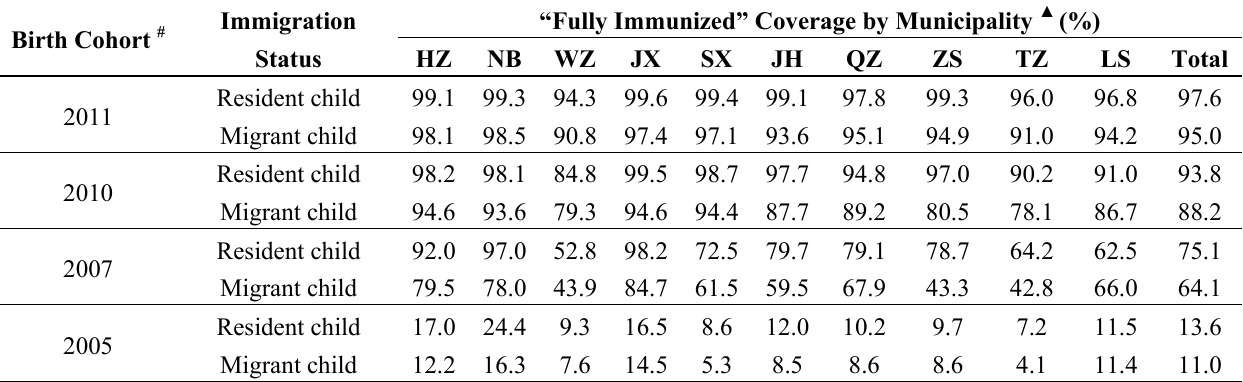
Table 7. Percentage of children “fully immunized” at 12 months, 24 months, 5 years and 7 years * of age, by 12-month wide cohorts, immigration status and municipality,